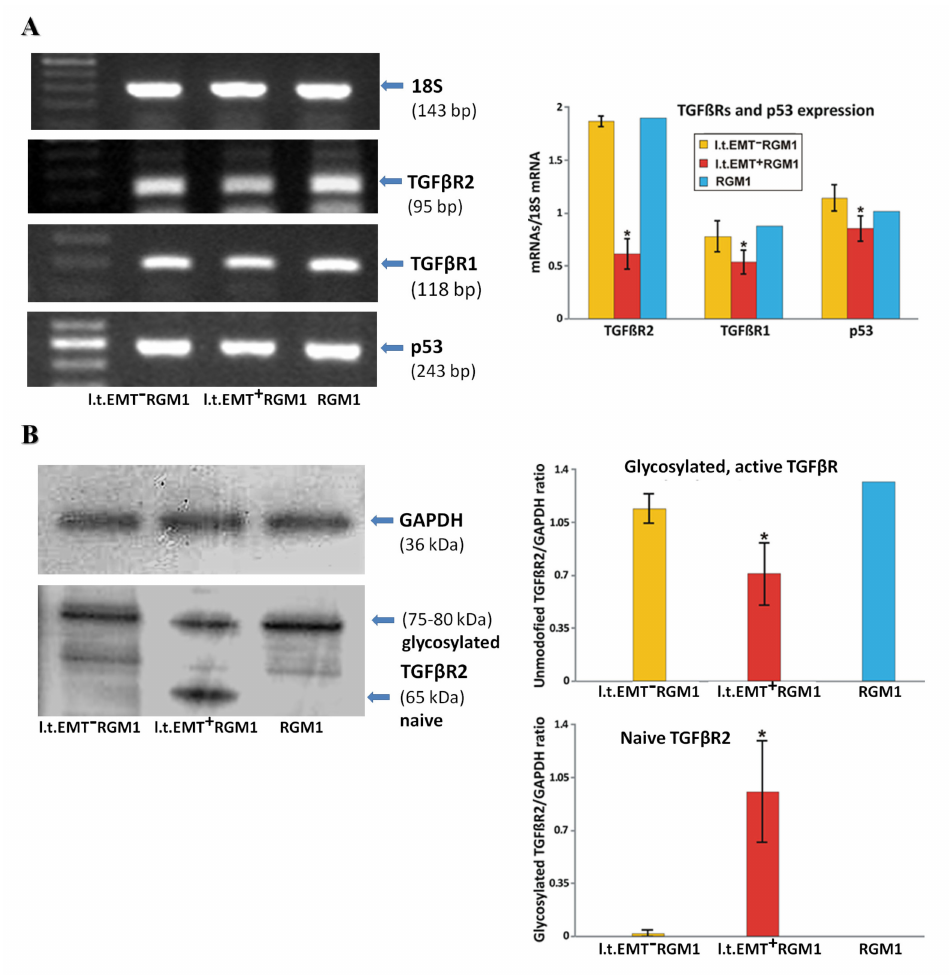
Figure 6. Di ff erential microevolution pattern of RGM1 cells is associated with di ff erently expressed TGF β Rs. ( A ) RT-PCR analysis of the expression of 18S mRNA and of TGF β Rs and p53 mRNA in l.t.EMT − RGM1 cells, l.t.EMT + RGM1 cells, and original RGM1 cells and the ratio of selected genes